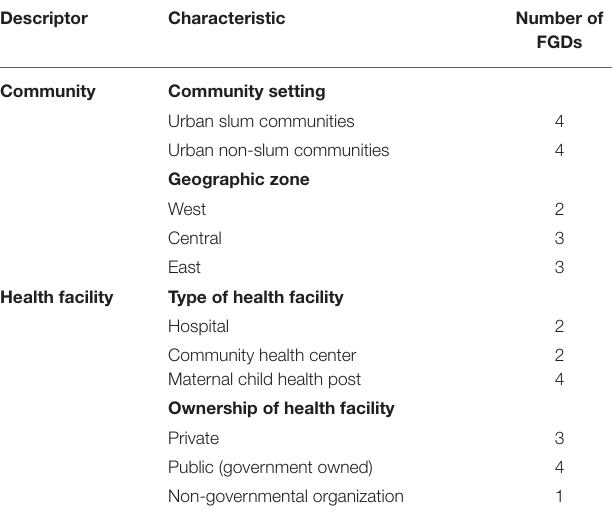
TABLE 1 | Characteristics of the focus group discussions with community health workers (CHWs), qualitative assessment, Western Area Urban, Sierra Leone,